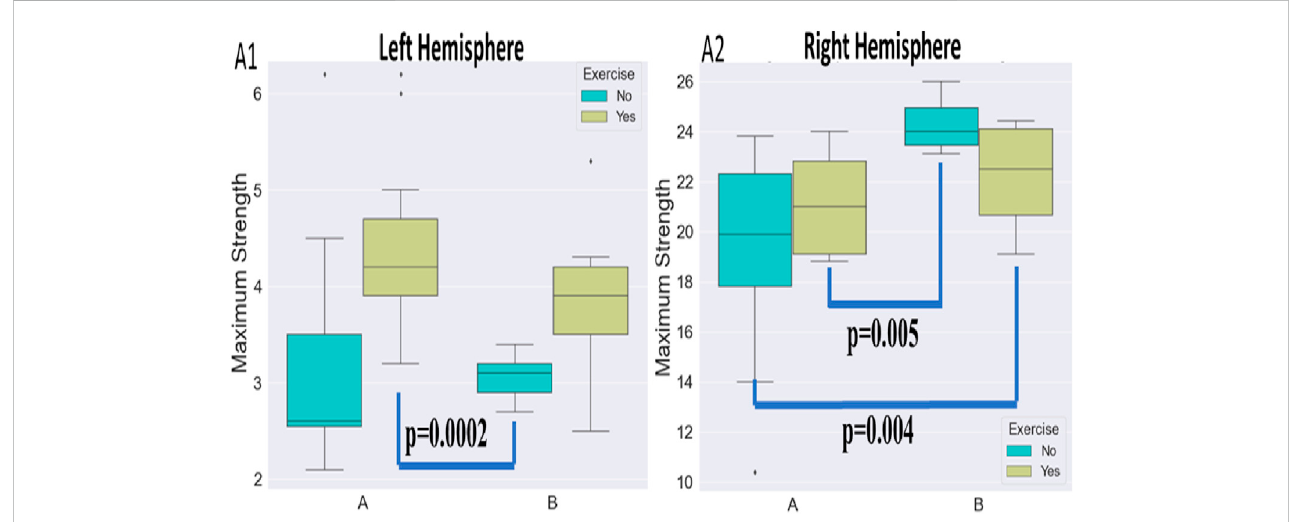
FIGURE 6 Visualization of maximum strength alterations for the left (A1) and right (A2) hemisphere and the various protocols.